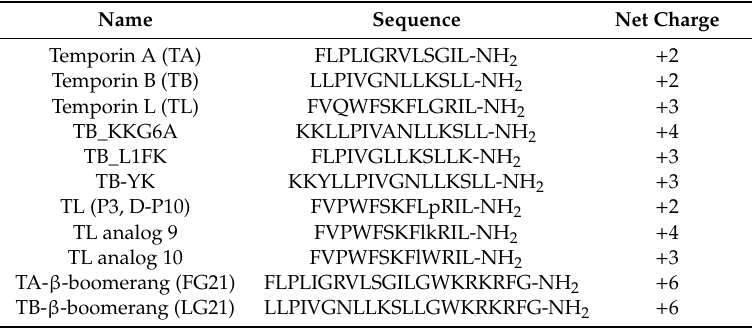
Table 1. Designed antimicrobial peptides (AMPs) derived from the frog skin Temporins